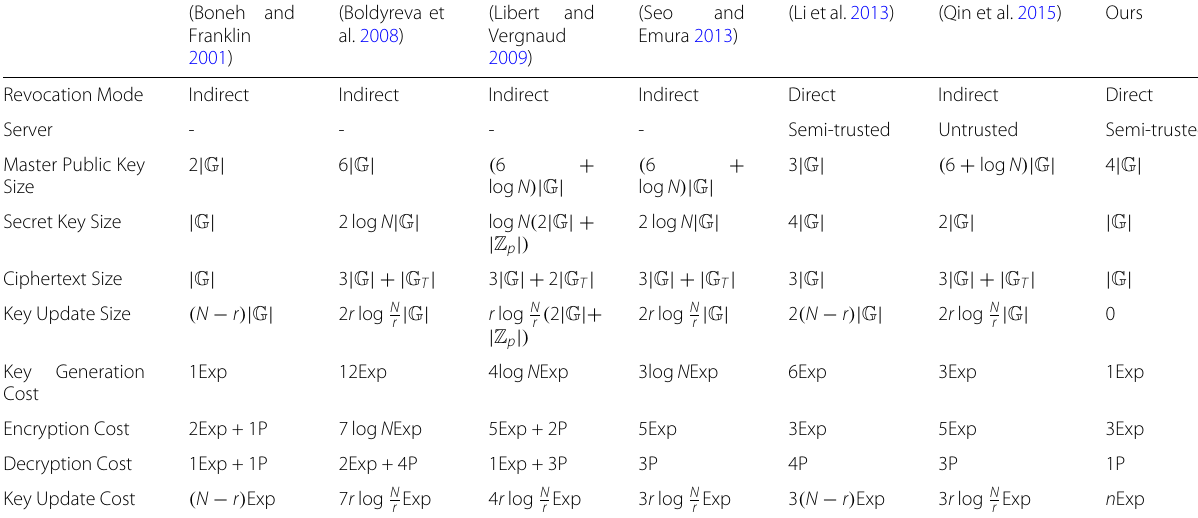
Table 2 Comparisons with revocable IBE